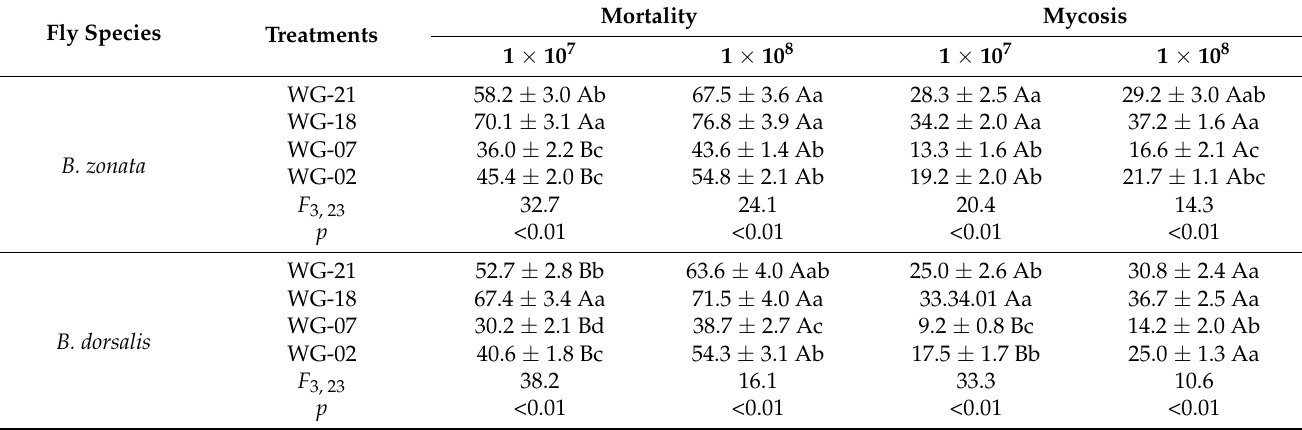
Table 7. Mortality and mycosis levels (% mean ± SEM) of the pupae and adults of B. zonata and B. dorsalis when pupae were exposed to four isolates of entomopathogenic fungi (WG-21, WG-18, WG-07, and WG-02) at two different concentrations (1 × 10 7 and 1 × 10 8 conidia mL − 1 ). Upper case letters between the rows and lower case letters within the column indicate no significant differences between isolates for mortality and mycosis ( p < 0.05; Tukey HSD test). Fly Species